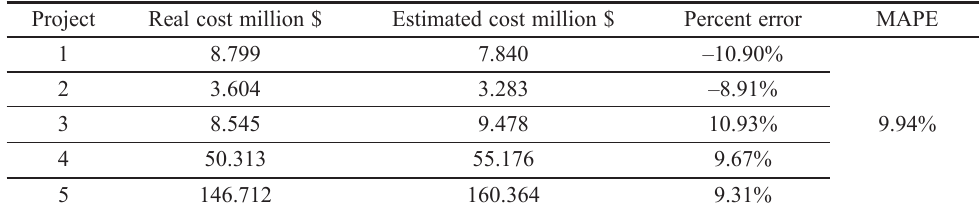
Fig. 2. RMSE behavior during analysis Table 3. Results of regression model cost estimations and